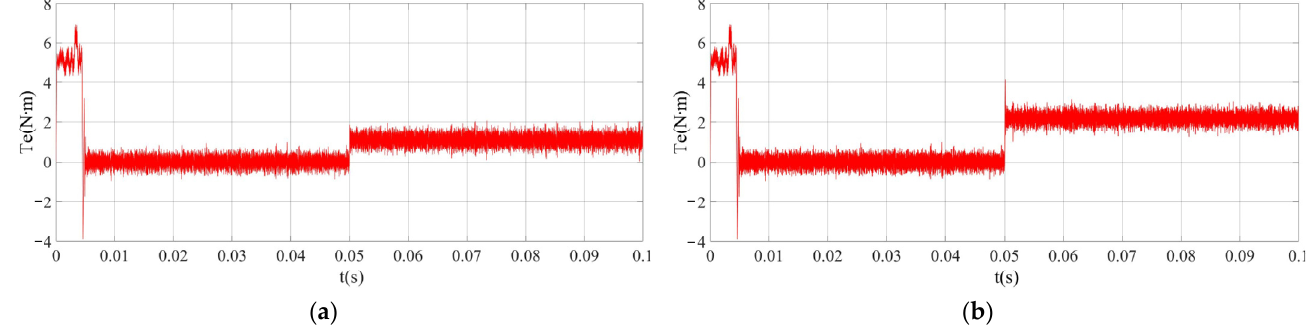
Figure 12. Torque performances of MPTC2 under different loads with speed of 3000 r/min: ( a ) 1.1 N·m; ( b ) 2.2 N·m.